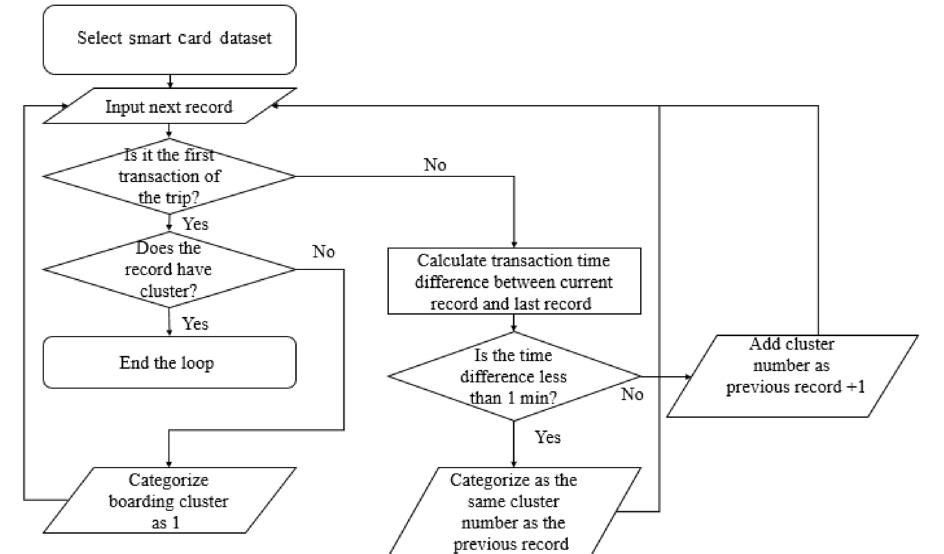
Fig. 2 Boarding cluster identification